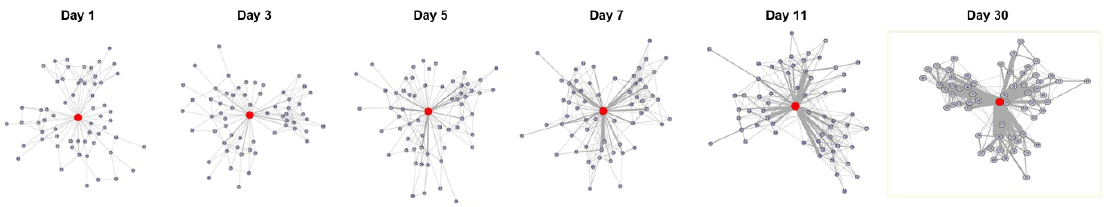
Figure 7. Aggregated view of the network showing the links actually used on a path towards each node over time.